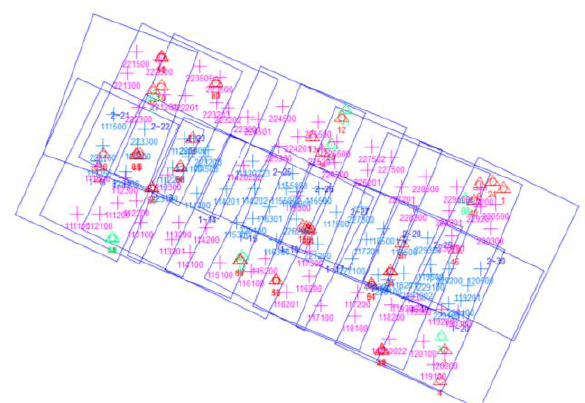
Figure 6. The measured tie points, pass point and control points on the image block